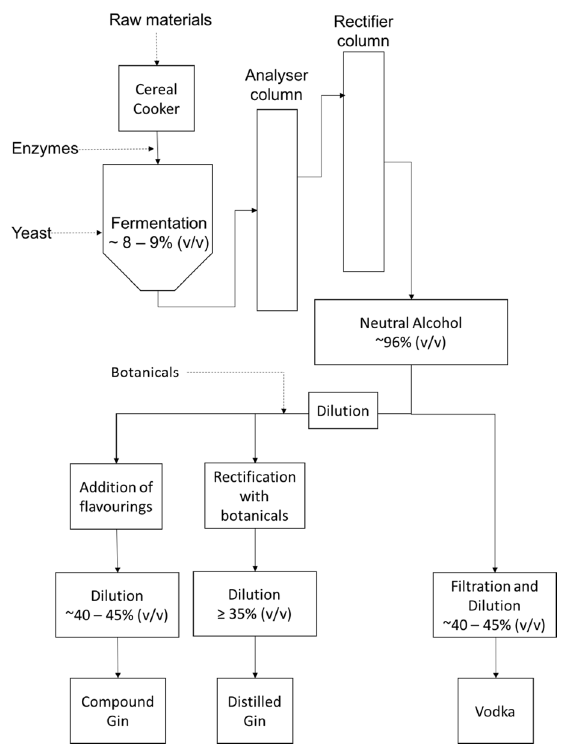
Figure 1. Simplified process diagram for the production of gin and vodka.